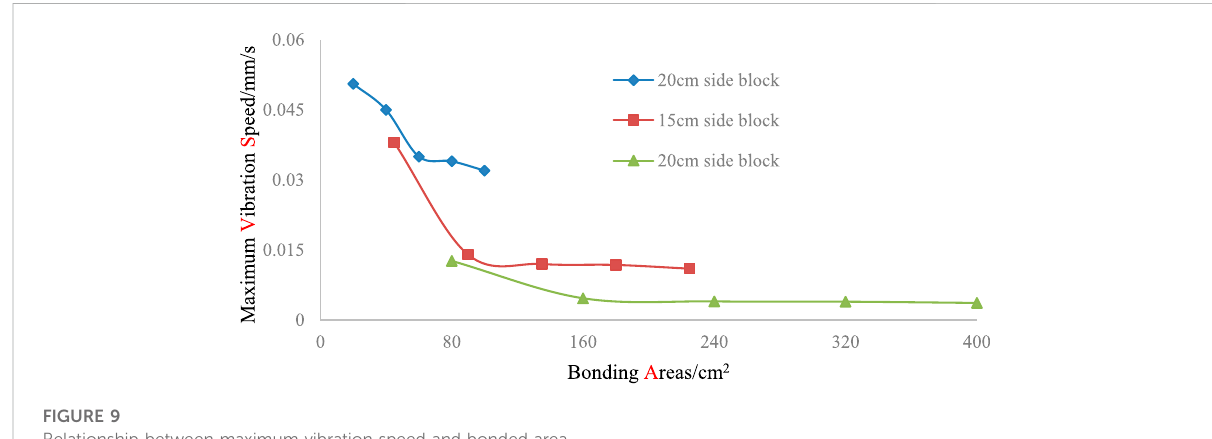
FIGURE 9 Relationship between maximum vibration speed and bonded